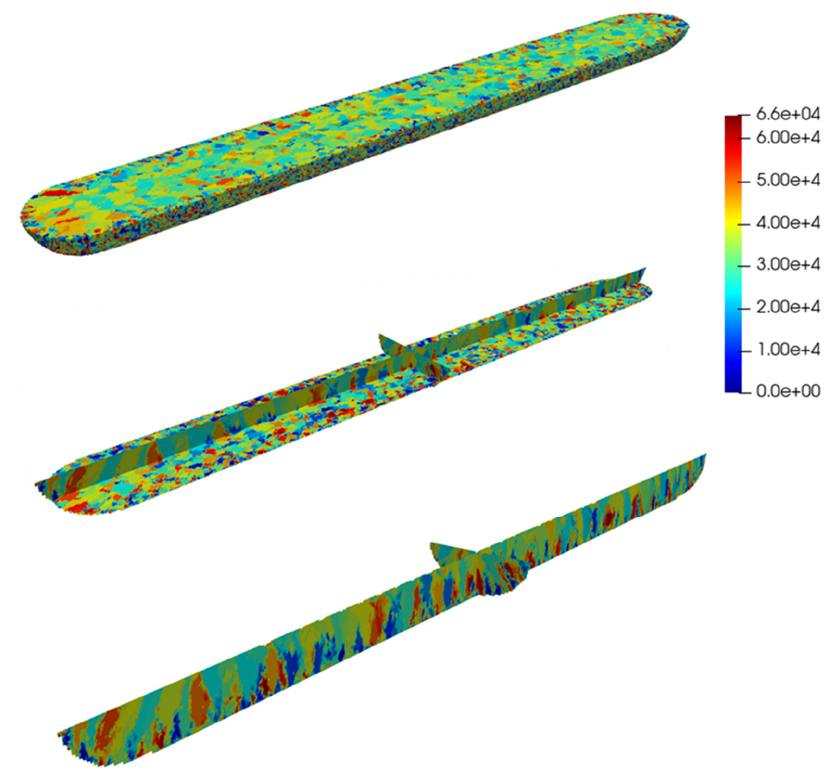
Figure 4. 3D grain structure simulation results (2D and 3D plots).